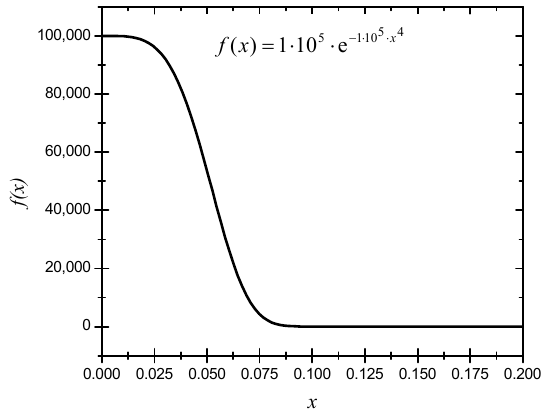
Figure 2. The plot of the function used in the dependent current source (BC